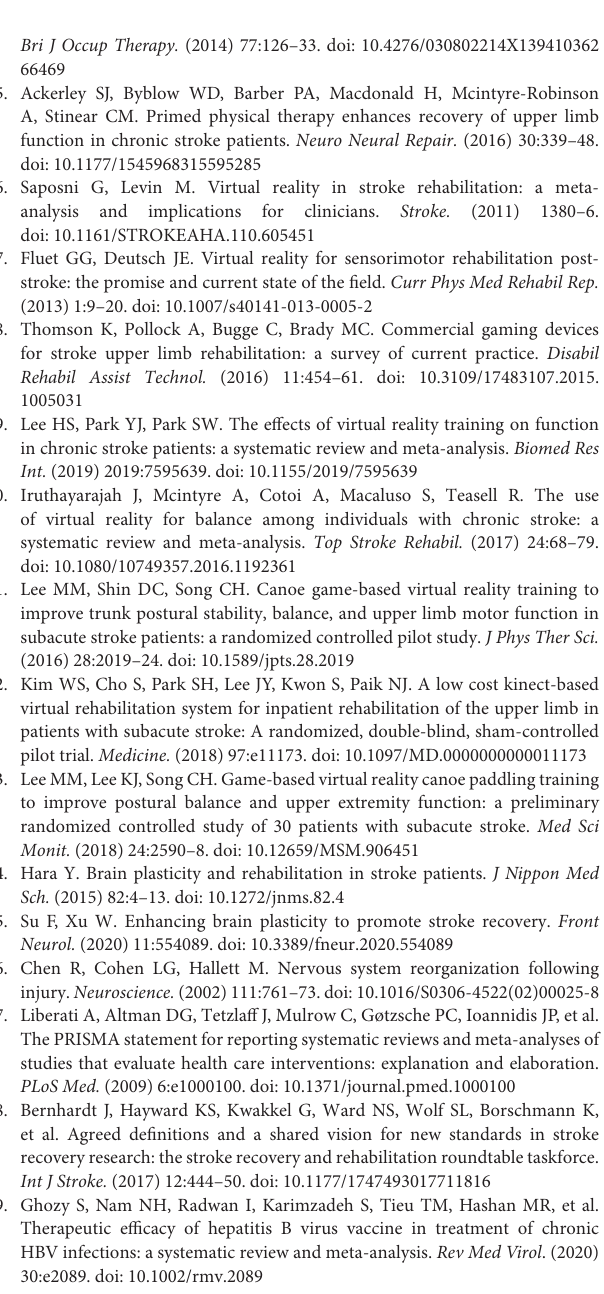
Supplementary Figure 1 | Baujat plot showing the contribution of each study into the overall heterogeneity. Supplementary Figure 2 | Leave-one-out sensitivity analysis for the effectiveness of virtual reality–based rehabilitation (preintervention vs. postintervention).